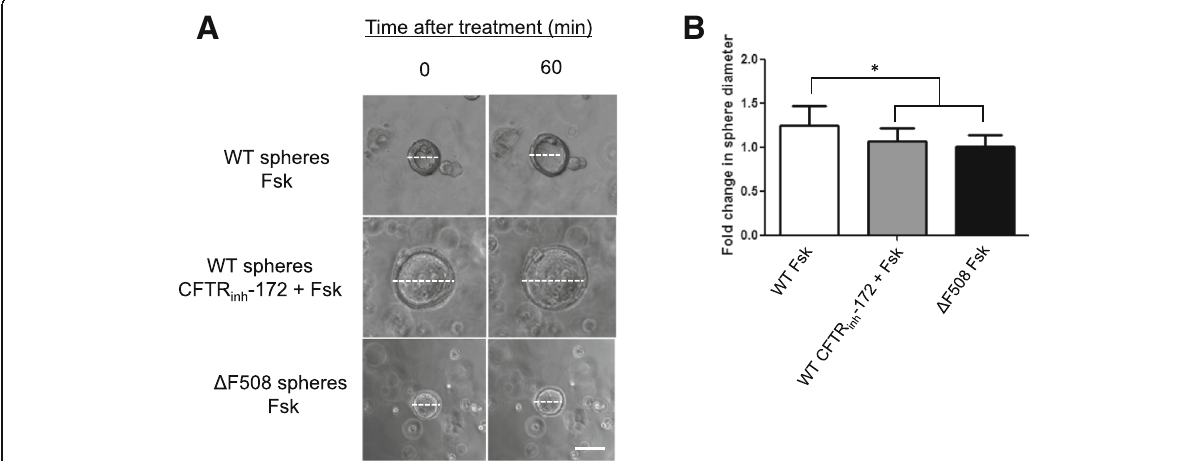
Fig. 3 Mouse CFTR Δ F508 IEC monolayers retains CFTR dysfunction in intestinal epithelium. a Representative images of WT and CFTR Δ F508 IEC monolayer derived spheroids grown in matrigel and treated with forskolin (Fsk) to induce spheroid swelling. Images were taken at 10× magnification. Scale bar: 100 μ m. White dashed line: representation of spheroid diameter measurement. b Quantification of WT and CFTR Δ F508 IEC monolayers swelling in response to CFTR activation (Forskolin, Fsk) and inhibition (CFTR inh -172). * p < 0.05, n = 3 individual animals in each treatment